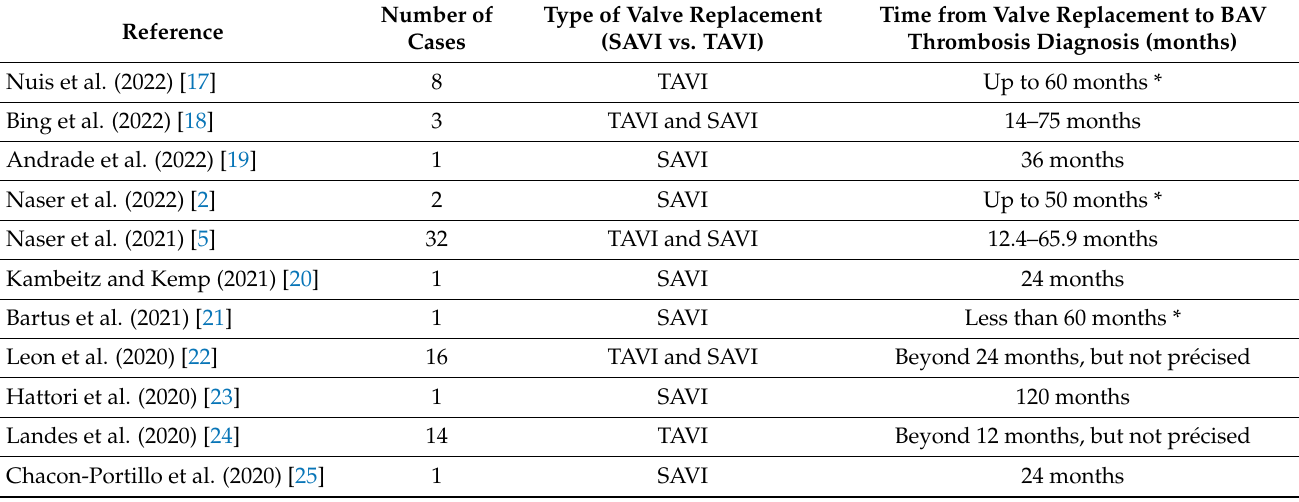
Table 2. A literature search of bioprosthetic aortic valve thrombosis with the time of